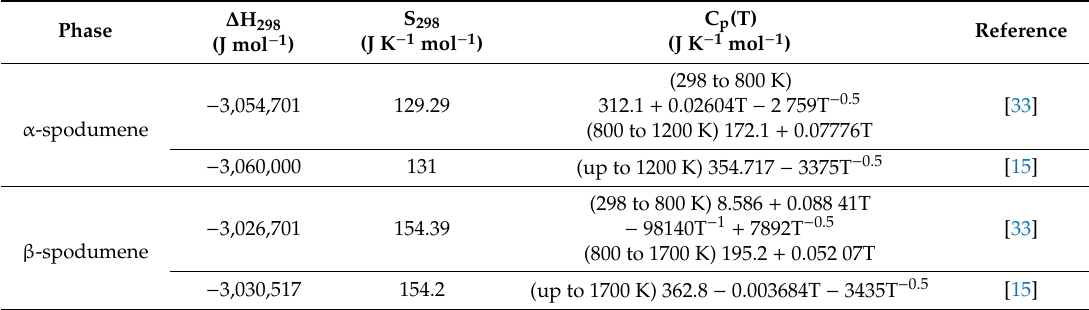
Table 1. Thermodynamic properties of α -spodumene and β -spodumene from Barin (data used by the FactSage software) [33] and Konar